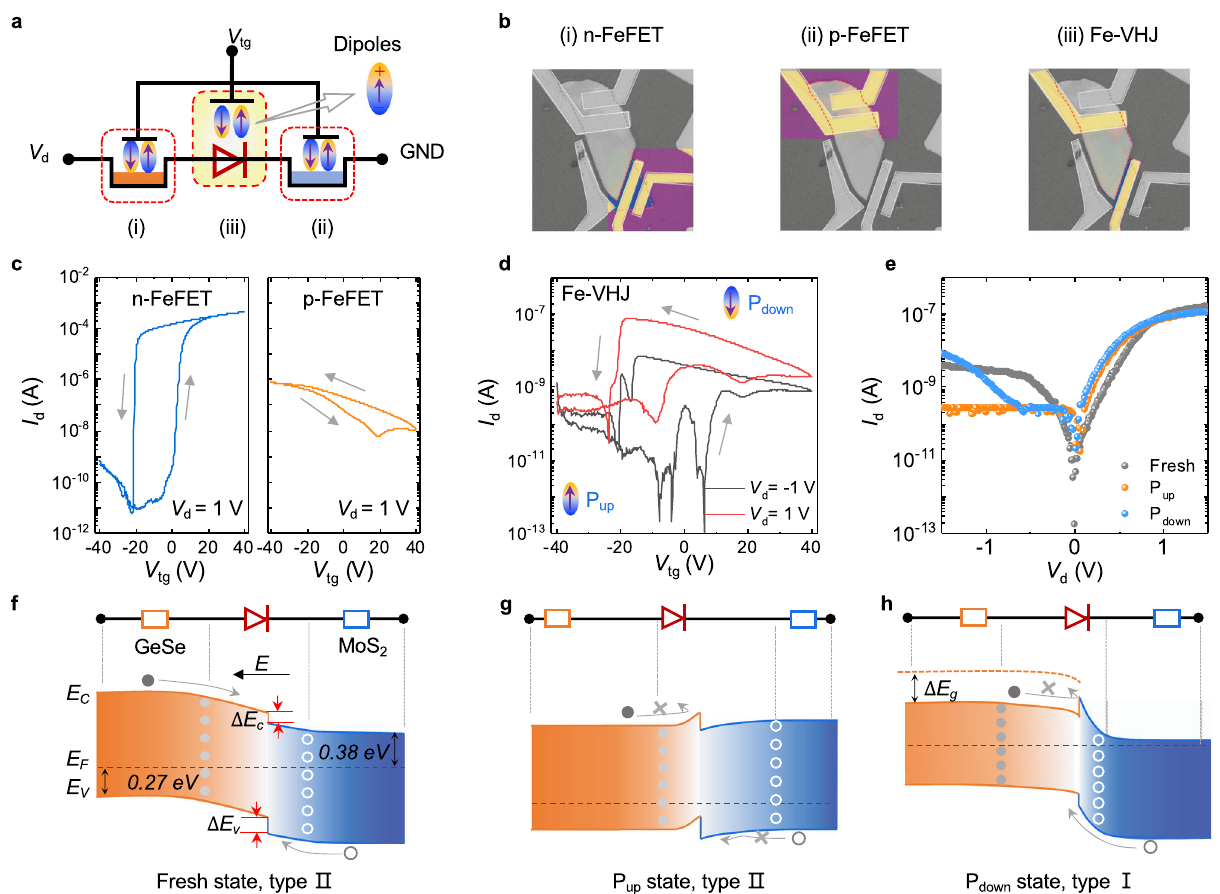
Fig. 2 Electrical properties of GeSe/MoS 2 heterojunction tuned by the ferroelectric polymer P(VDF-TrFE). a Electrical con fi guration of the device, with three parts represented in the dashed-line frames. b Optical image of three device elements: MoS 2 n-FeFET, GeSe p-FeFET, and GeSe/MoS 2 Fe-VHJ. c Transfer characteristics of GeSe p-FeFET and MoS 2 n-FeFET at V d = 1 V. d Transfer characteristics of the Fe-VHJ under forward and reverse biases. e Output characteristics of the GeSe/MoS 2 heterojunction when P(VDF-TrFE) are fresh, polarized upward, and polarized downward states. f Schematic of the energy band structure of the GeSe/MoS 2 junction at “ Fresh ” state. E F - E C and E F - E v were calculated using experimental data. Schematic of the heterojunction energy bands at an equilibrium state. Bandgap evolution of the GeSe/MoS 2 Fe-VHJ at g “ P up ” state and h “ P down ”